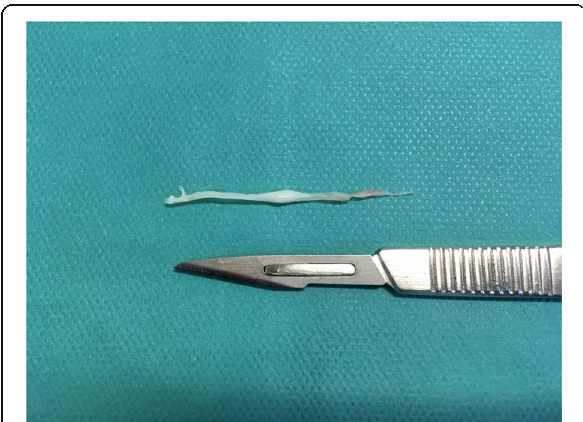
Fig. 6 The fibrous band after